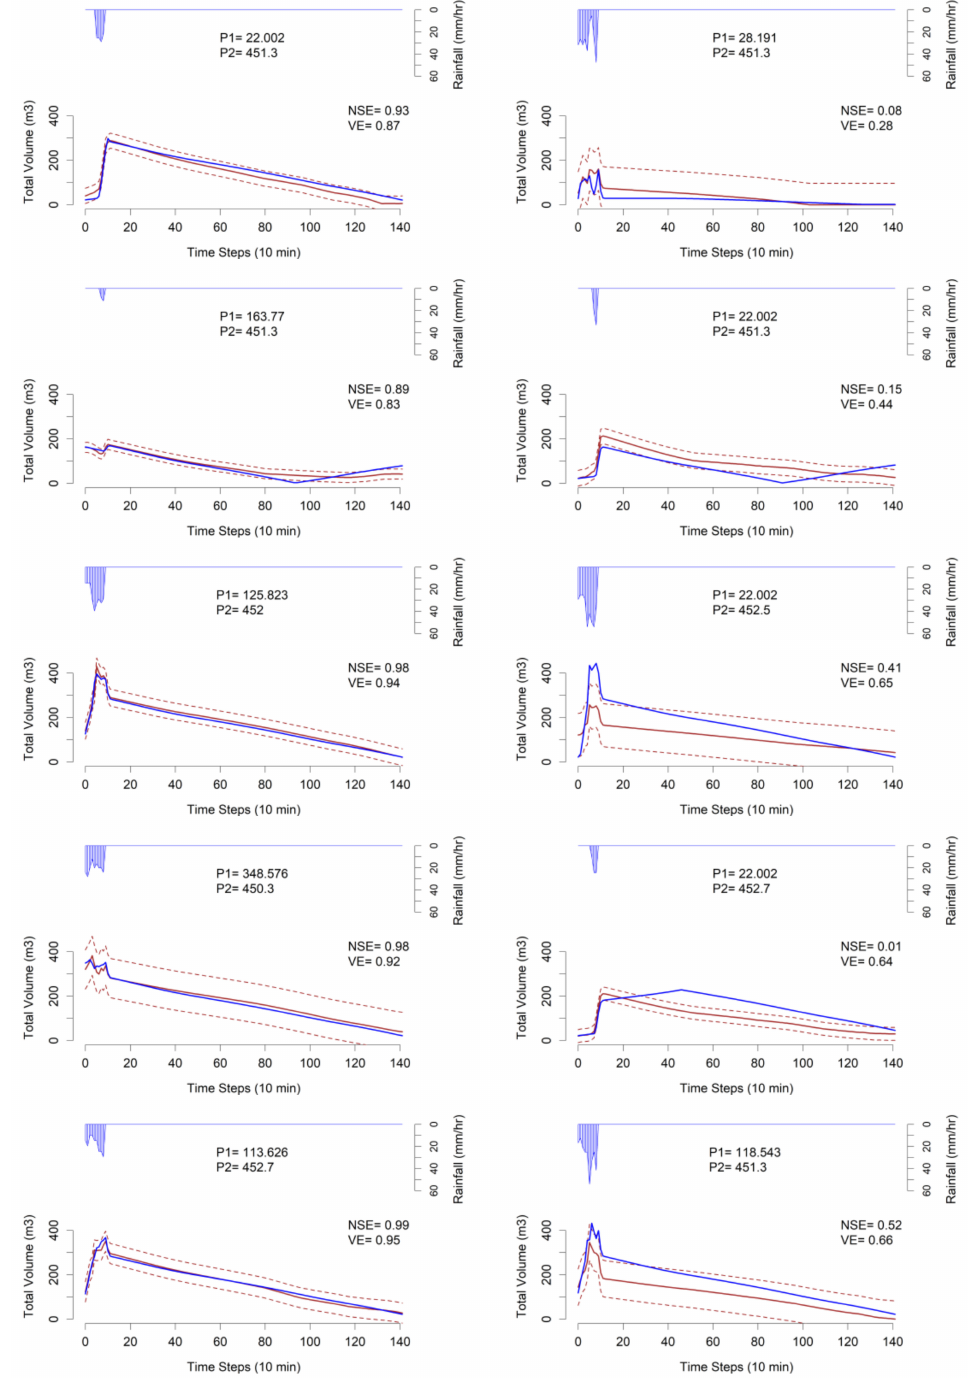
Figure 4. Comparison of emulator (solid red line) vs. simulator (blue line) results for 10 sample scenarios from the validation dataset. Some random high quality predictions ( left column ) as well as poor predictions ( right column ) are shown. P1: initial tank volume (m 3 ); P2: pump switch on level (m AD); 95% confidence interval for emulator prediction (CI95 = 1.96 × std) is shown in dashed red lines; std is the standard